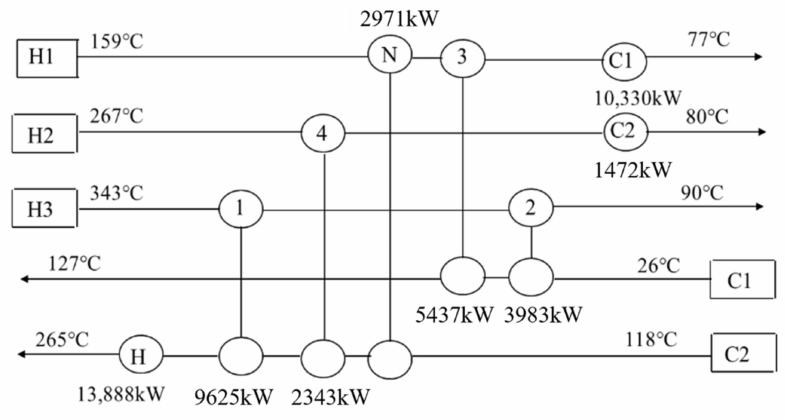
Figure 9. Adding a new plate heat exchanger for case study 1.